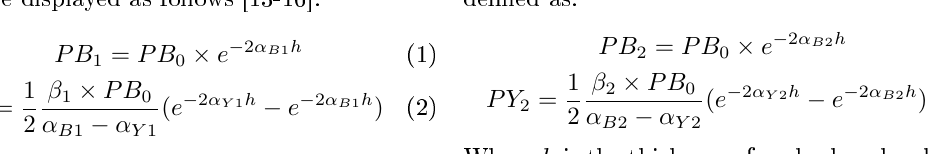
light. γ is the reflection coefficient of the yellow light. The intensities of blue light ( PB ) and yellow light ( PY ) are the blue and yellow lights during their propagation in the phosphor layer respectively. The lighting efficiency of pc-